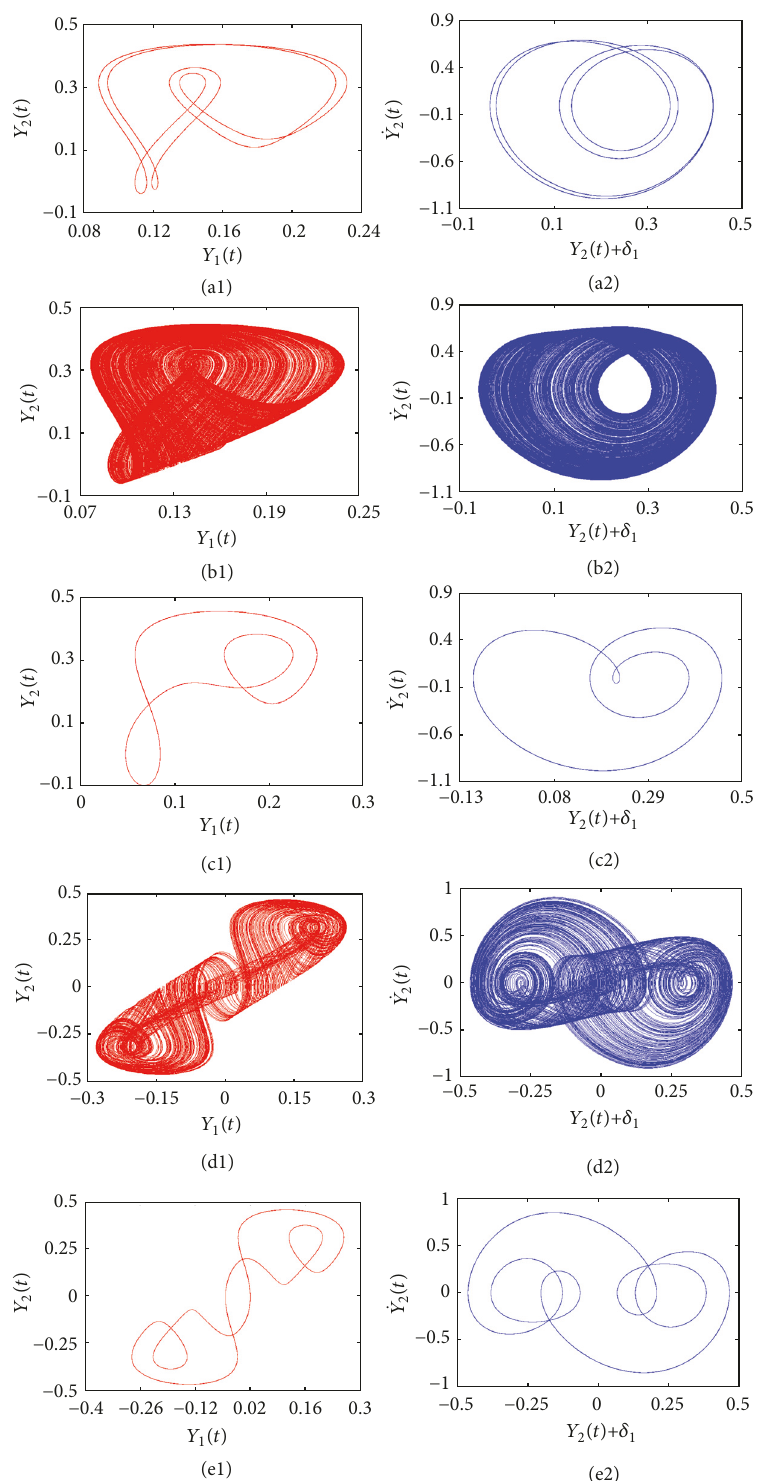
Figure 14: Phase portraits numerically simulated by MATLAB for different values of 𝛿 4 , in which 𝛿 1 = 0, 𝛿 2 = 0.1, and 𝛿 3 = 0. (a) 𝛿 4 = − 22. (b) 𝛿 4 = − 19. (c) 𝛿 4 = − 16. (d) 𝛿 4 = − 10. (e) 𝛿 4 = −